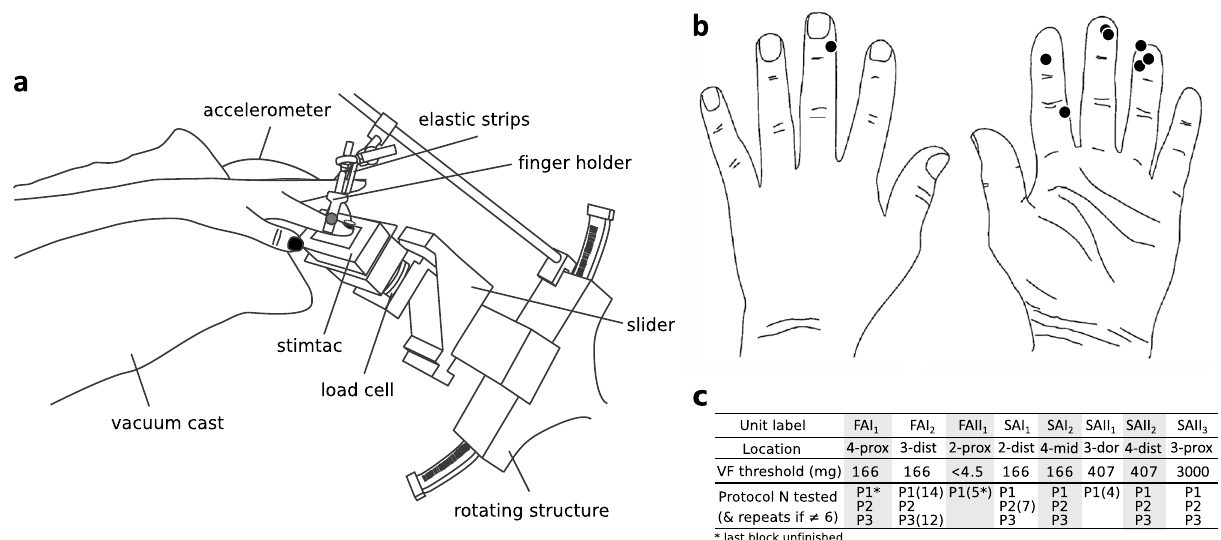
Figure 1. Experimental set-up and unit locations on the hand. ( a ) Stimtac unit mounted on the robot platform and its adjustable mount. ( b ) Locations of the centers of Receptive Fields (RFs) of the 8 mechanoafferent units evaluated in the paper. ( c ) Summary table of the unit characteristics, from top to bottom: unit label, location (2–3–4 for index-major-ring fingers; prox proximal, dist distal, mid middle, dor dorsal), Von Frey threshold, protocols performed, and number of repeats of blocks per